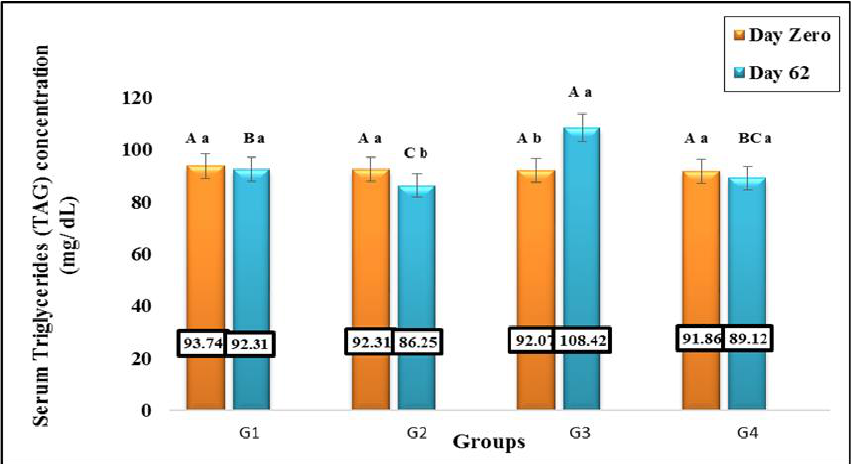
Figure 2. Effect of phosphatidylcholine, fructose and/or combination on triglycerides concentration (mg/dL). Mean ± SE, n = 9 in a group. G1 control groups (C), G2: (Pc), G3: (Fr), G4: (Fr + Pc).